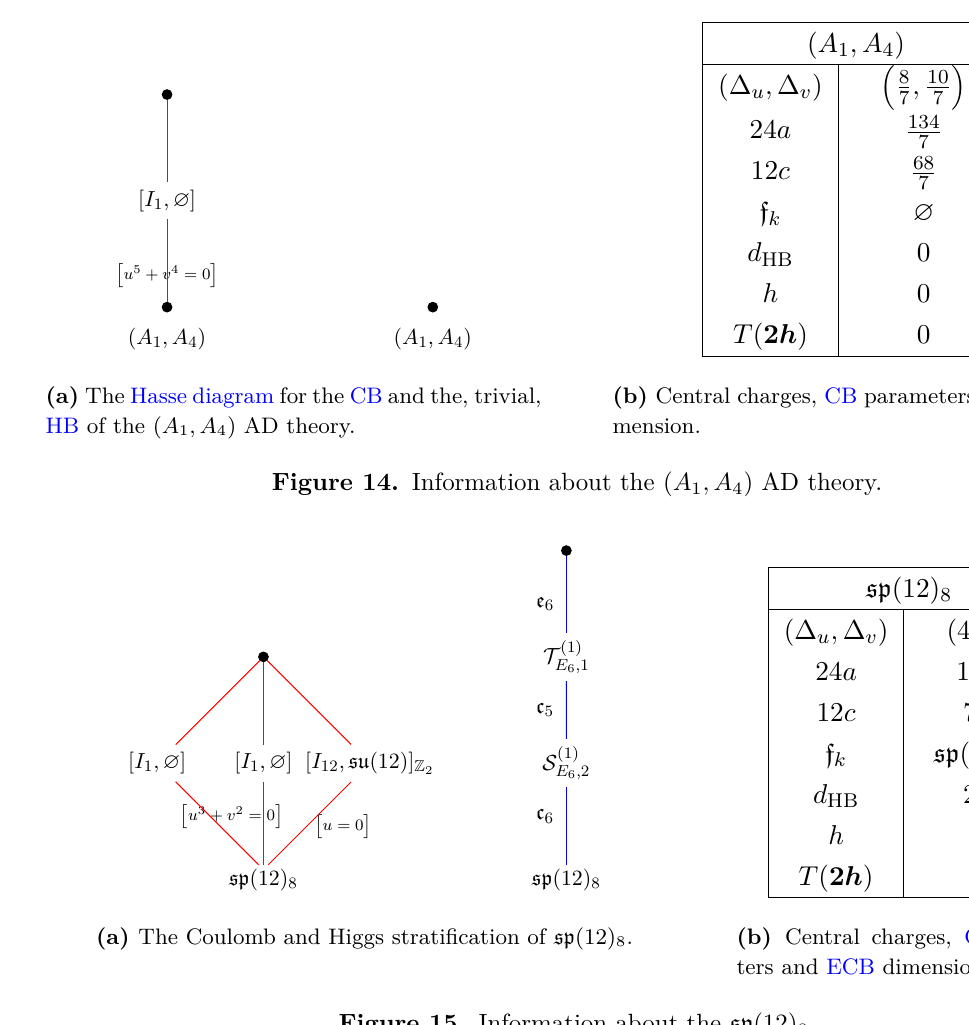
Figure 15. Information about the sp (12) 8